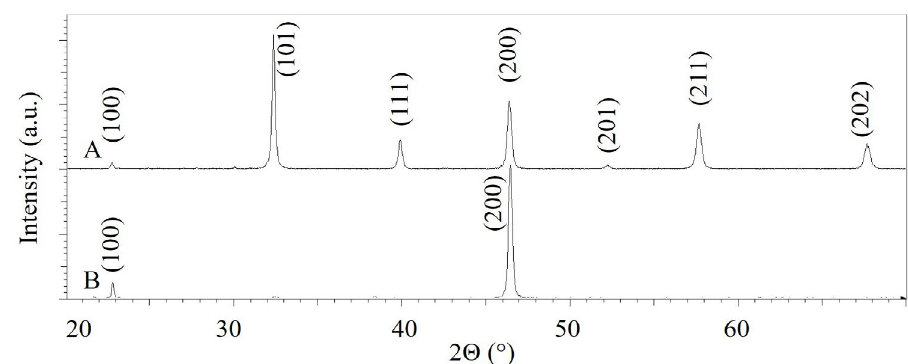
Figure 4: XRD patterns of SrTiO 3 powder prepared from BIT8 (pattern A) and SrTiO 3 plates cast on the Si single crystal (pattern B). XRD pattern of the